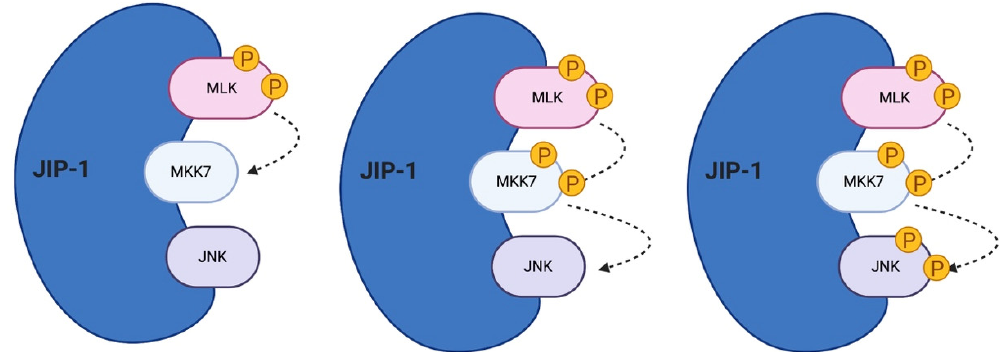
Figure 2. JNK’s sca ff old protein JIP-1. JIP-1 is a crucial regulator of the JNK signaling pathway. It links multiple MAPK members, tethering them together and accelerating the reaction cascade. JIP-1 regulates signal transduction and helps localize pathway in components of the cell such as the plasma membrane, the cytoplasm, the nucleus, the Golgi and in neurons in the pre- and post-synaptic elements. JIPs coordinate the JNK-module and can also bind other proteins, including kinesin light chain (KLC) [57] and APP [58], influencing the cellular response to distinct stimuli, such as cytokines (IL1, and overlapping functions [53]. JIP-proteins link both positive and negative JNK signaling